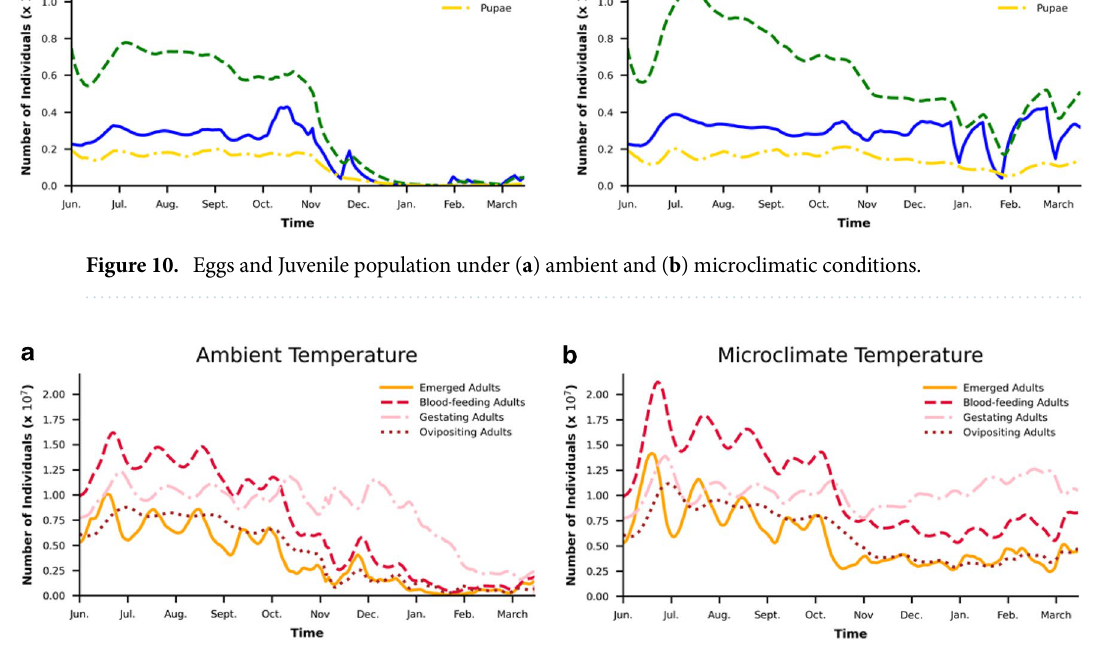
Figure 11. Adult mosquito population under ( a ) ambient and ( b ) microclimatic